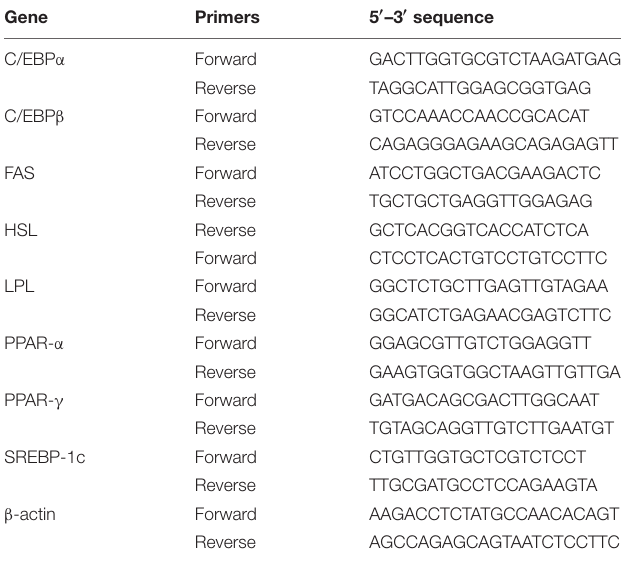
TABLE 1 | Primers used for the real-time PCR analysis of genes involved in adipogenesis and lipolysis. Gene Primers 5 (cid:48) –3 (cid:48) sequence